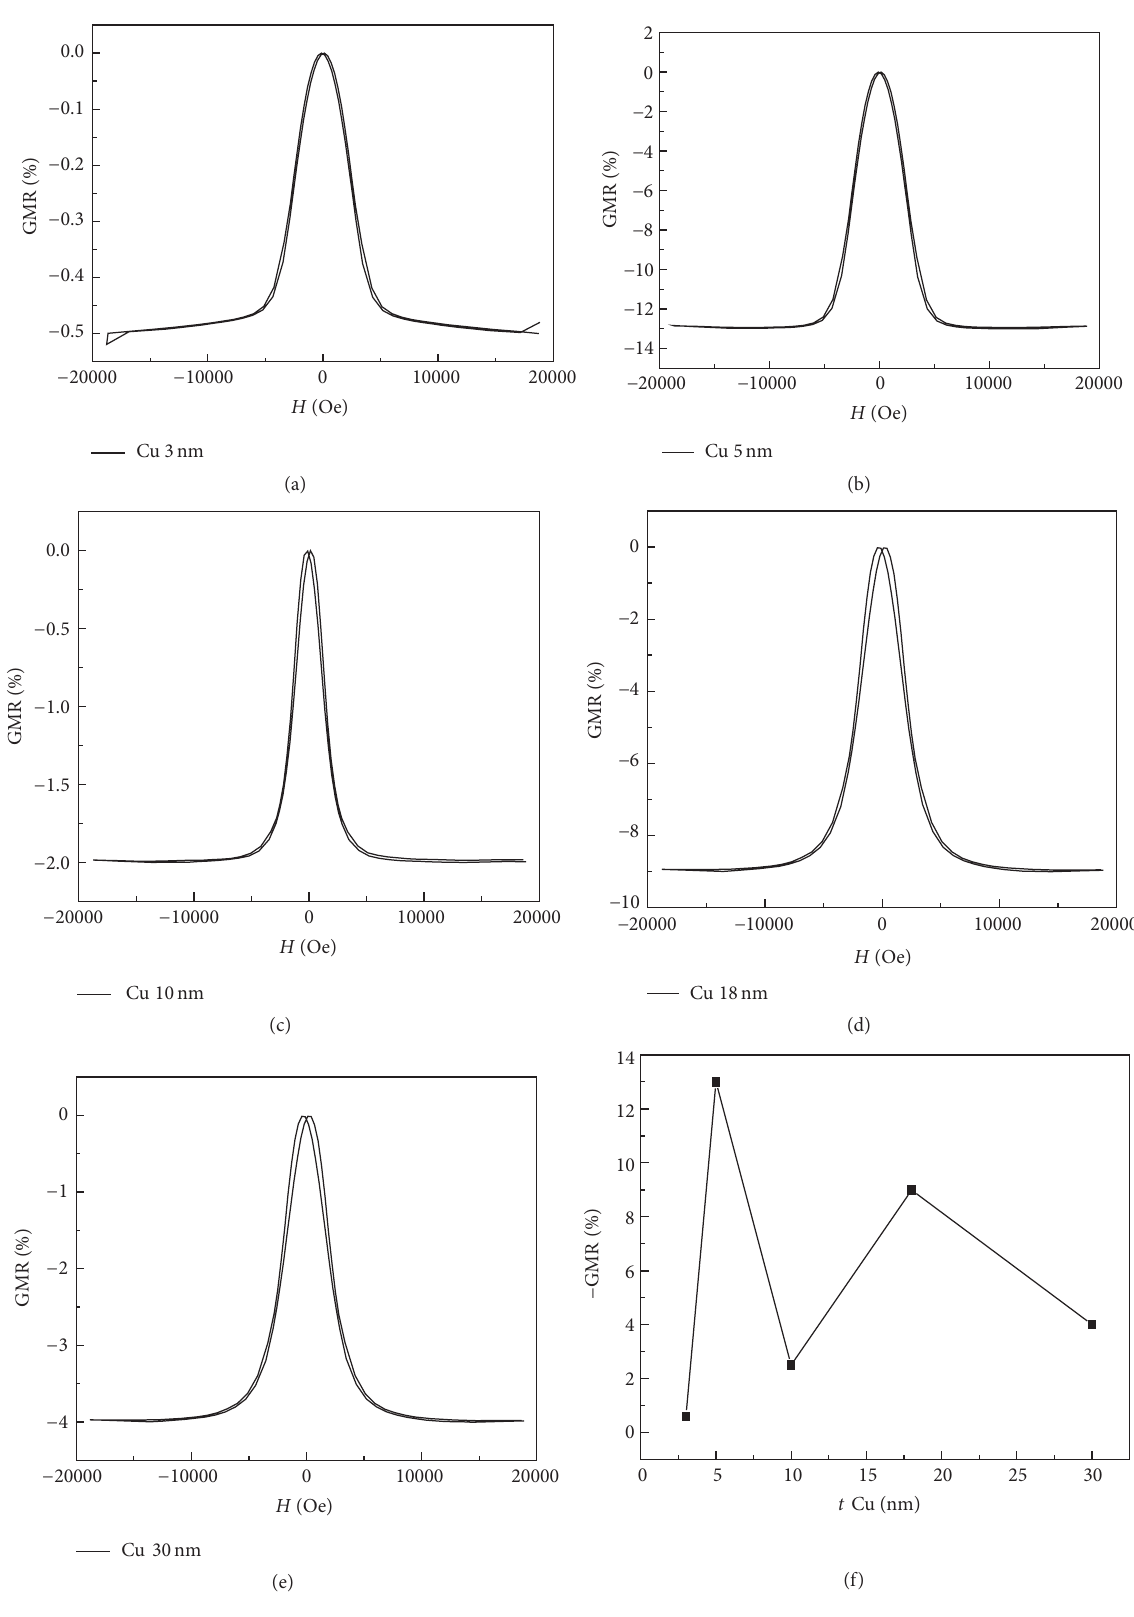
Figure 5: (a)–(e) The CPP-GMR curves of Co (50 nm)/Cu (3 nm), Co (50 nm)/Cu (5 nm), Co (50 nm)/Cu (10nm), Co (50 nm)/Cu (18nm), and Co (50nm)/Cu(30nm) multilayered nanowirearrays under applied magnetic field parallel to thenanowires. (f)Therelationship between the CPP-GMR ratio and different thicknesses of the Cu layer of the Co/Cu multilayered nanowire arrays under magnetic field parallel to the